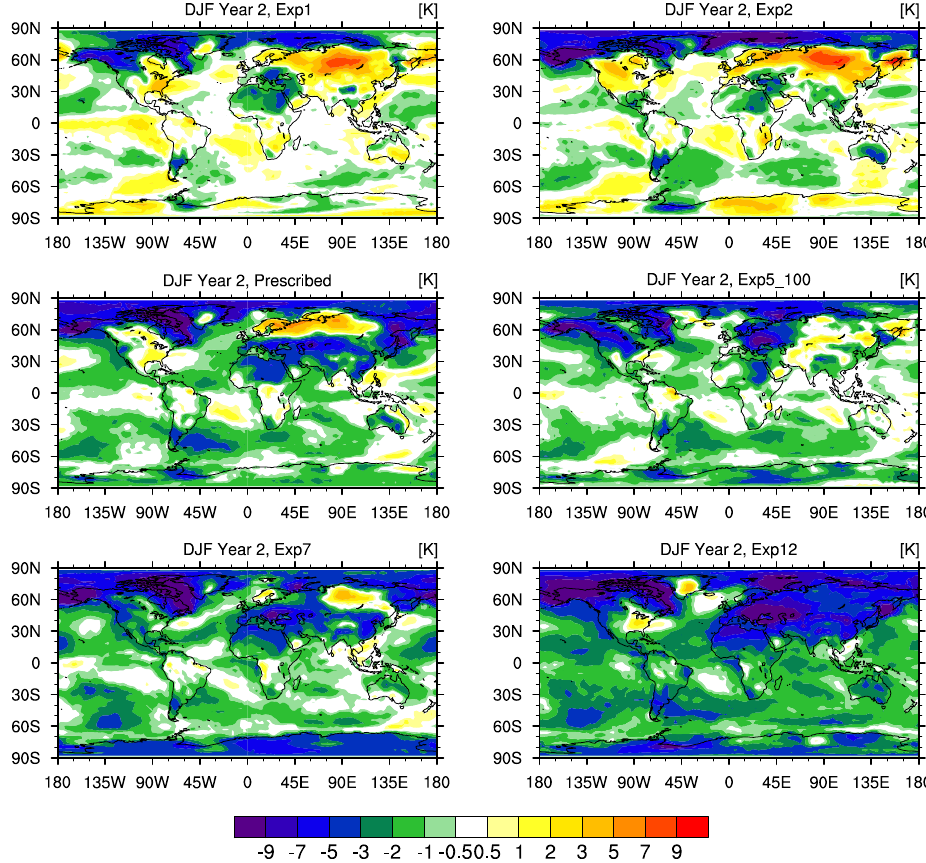
Fig. 7. Same as Fig. 6, but averaged for December, January, and February of the second